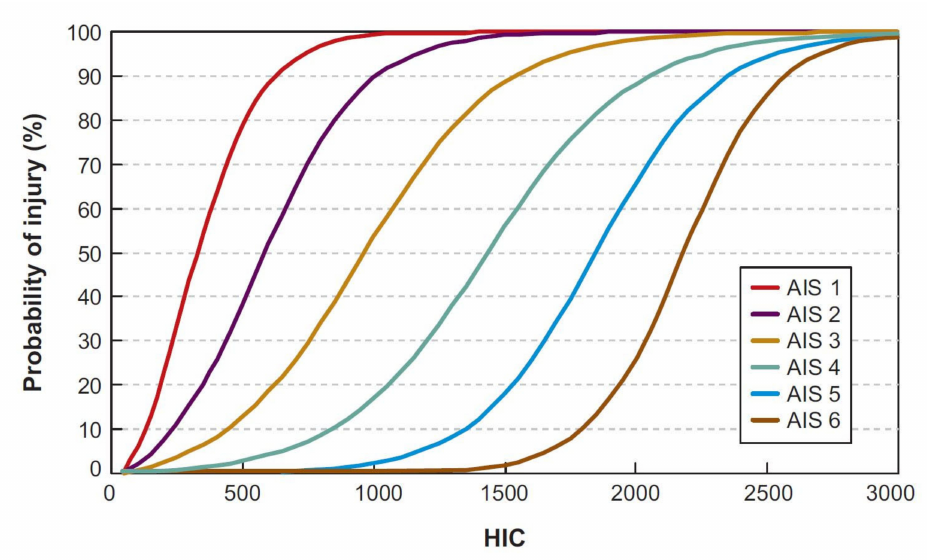
Figure 9. Head injury risk curves, according to the AIS scale, based on the head injury criterion